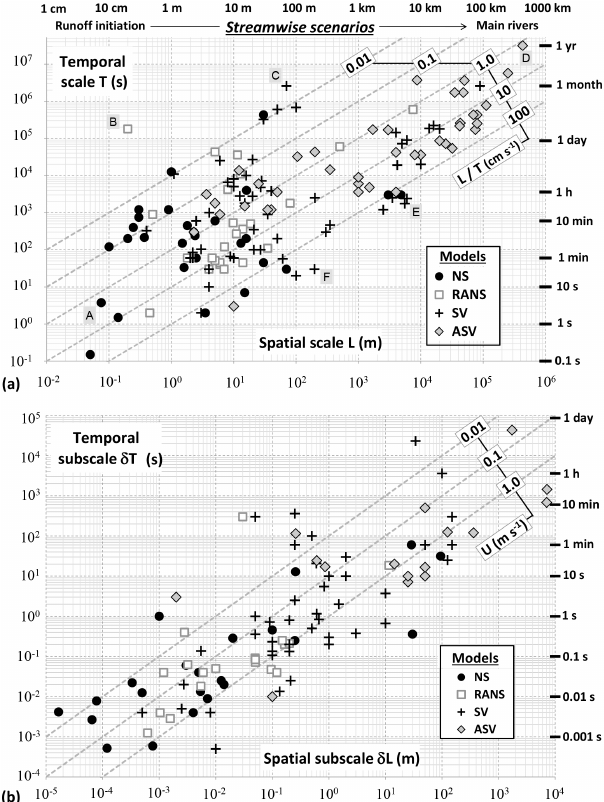
Figure 2. How increasing ( L , T ) spatiotemporal scales (a) and ( δL , δT ) subscales (b) of the flow domain tend to be associated with de- creasing complexity in the choice of flow models, sorted here into four levels of refinement: Navier–Stokes (NS), Reynolds-averaged Navier–Stokes (RANS), Saint-Venant (SV), or approximations to Saint-Venant (ASV). A transverse analysis involves forming L/T ratios, searching for clues to model selection according to these “system evolution velocities” or governed by flow typologies that would exhibit specific L/T ratios (a) . Unit values of the Courant number ( Cr = UδT/δL ) have been used to trace characteristic flow velocities of U = 0 . 01, 0.1, and 1ms − 1 , and the indicative numer- ical stability criterion is Cr ≤ 1: for given δL and U values, δT should lie behind the dotted line (b) . Both plots were assembled from information available in the studies cited in Appendix A, se- lecting six textbook cases (sketches A to F, Table 1) for illustration (a)